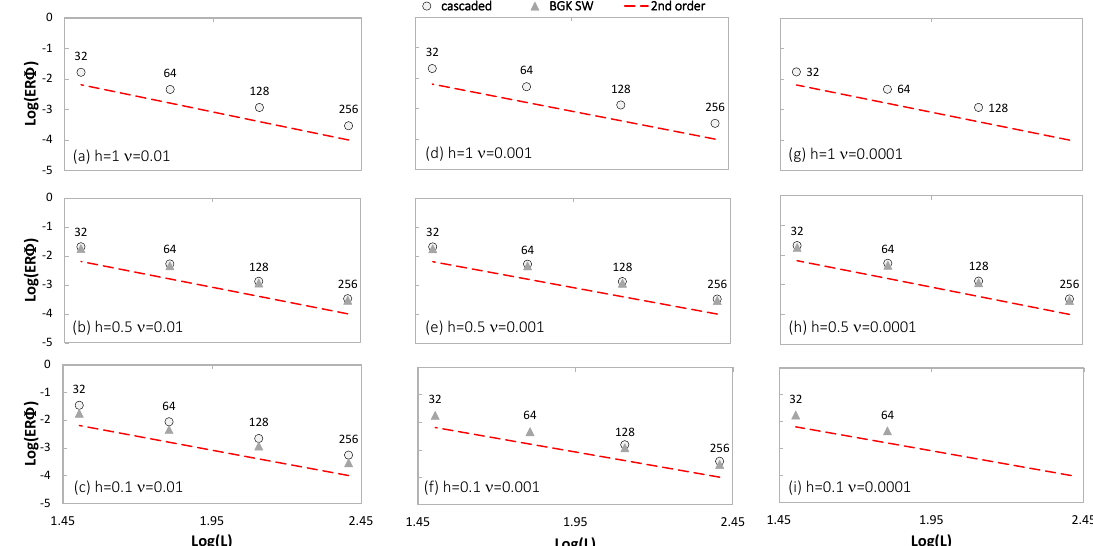
Figure A4. Taylor Green Vortex test. Fast velocity set—phase lag ER Φ , for the three depths: h = 1.0, h = 0.5, and h = 0.1 and three viscosities: ν = 0.01, 0.001, and 0.0001. The label shows the different values of the domain width L